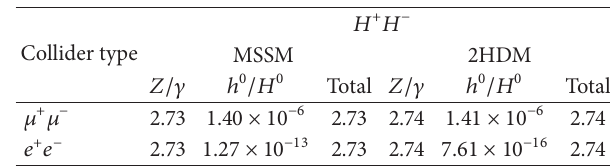
and 𝜇 + 𝜇 − colliders at √𝑠 = 3 TeV. The Higgs boson masses are 𝑚 𝐻 = = 𝑚 = 500 𝑚 𝐴 𝐻 ±